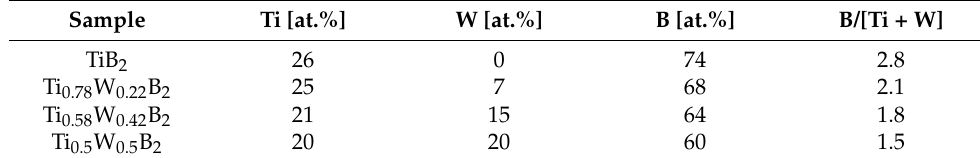
Table 1. The concentrations of elements across the coatings determined by XPS.